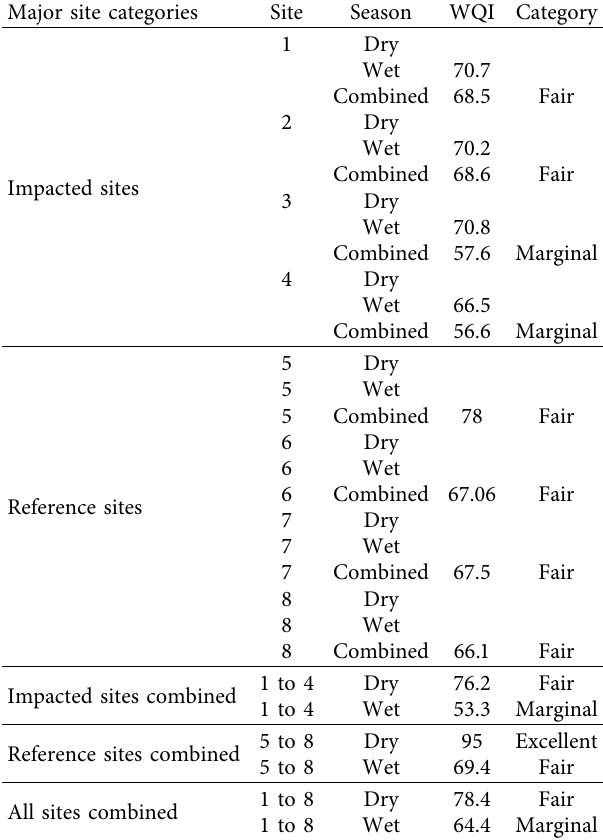
Table 5: Water quality index (WQI) calculated for the sampled sites at the Southern Gulf of Lake Tana using both bacteriological (coliforms) and physicochemical parameters,